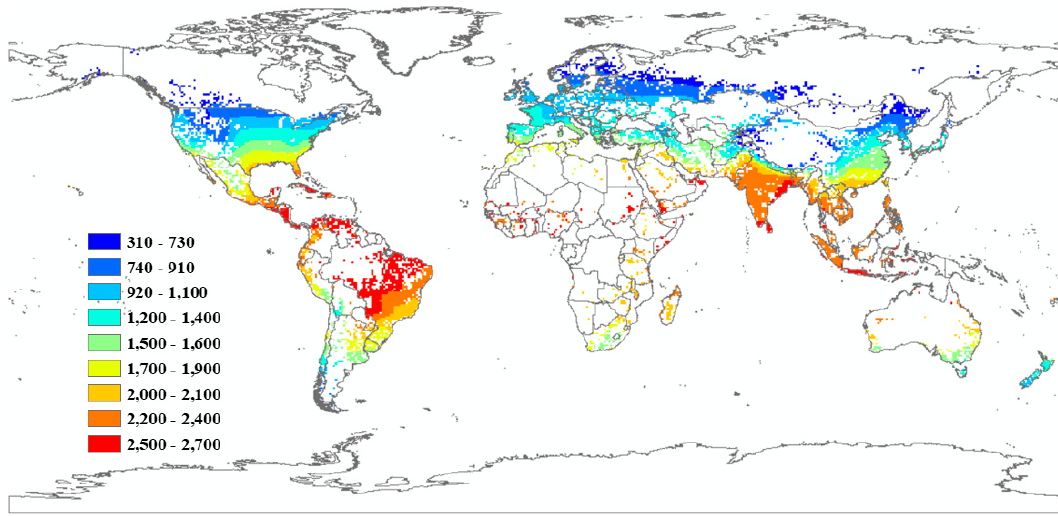
Figure 8. Net irrigation water requirement of GFDL model in 2050 (RCP8.5). The same irrigated area than in 1960 is used the same in figure 1.